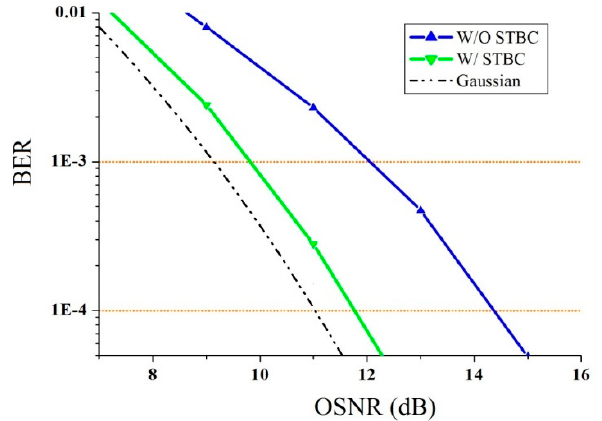
Figure 16. The bit error rate (BER) vs. optical signal-to-noise ratio (OSNR) comparison for PDM-QPSK signal in LP 11a mode with or without using the STBC-RLS scheme [31].